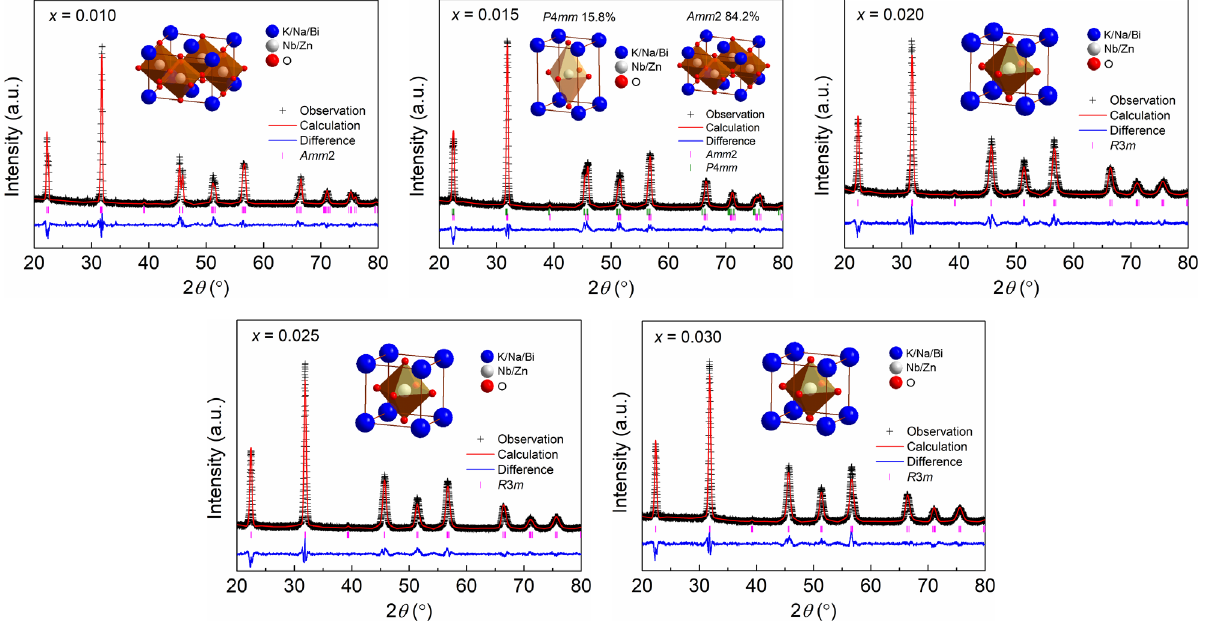
Fig. 2 Rietveld refinements for (1 − x )KNN − x BZN ( x = 0.010, 0.015, 0.020, 0.025, and 0.030) ceramics at